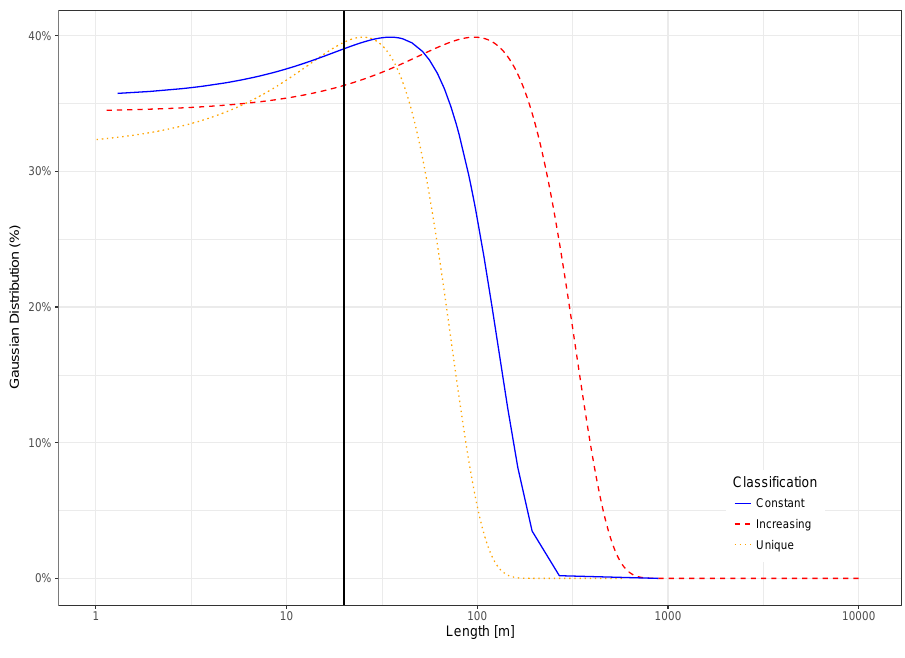
Figure 8. Normal distribution of segments length.